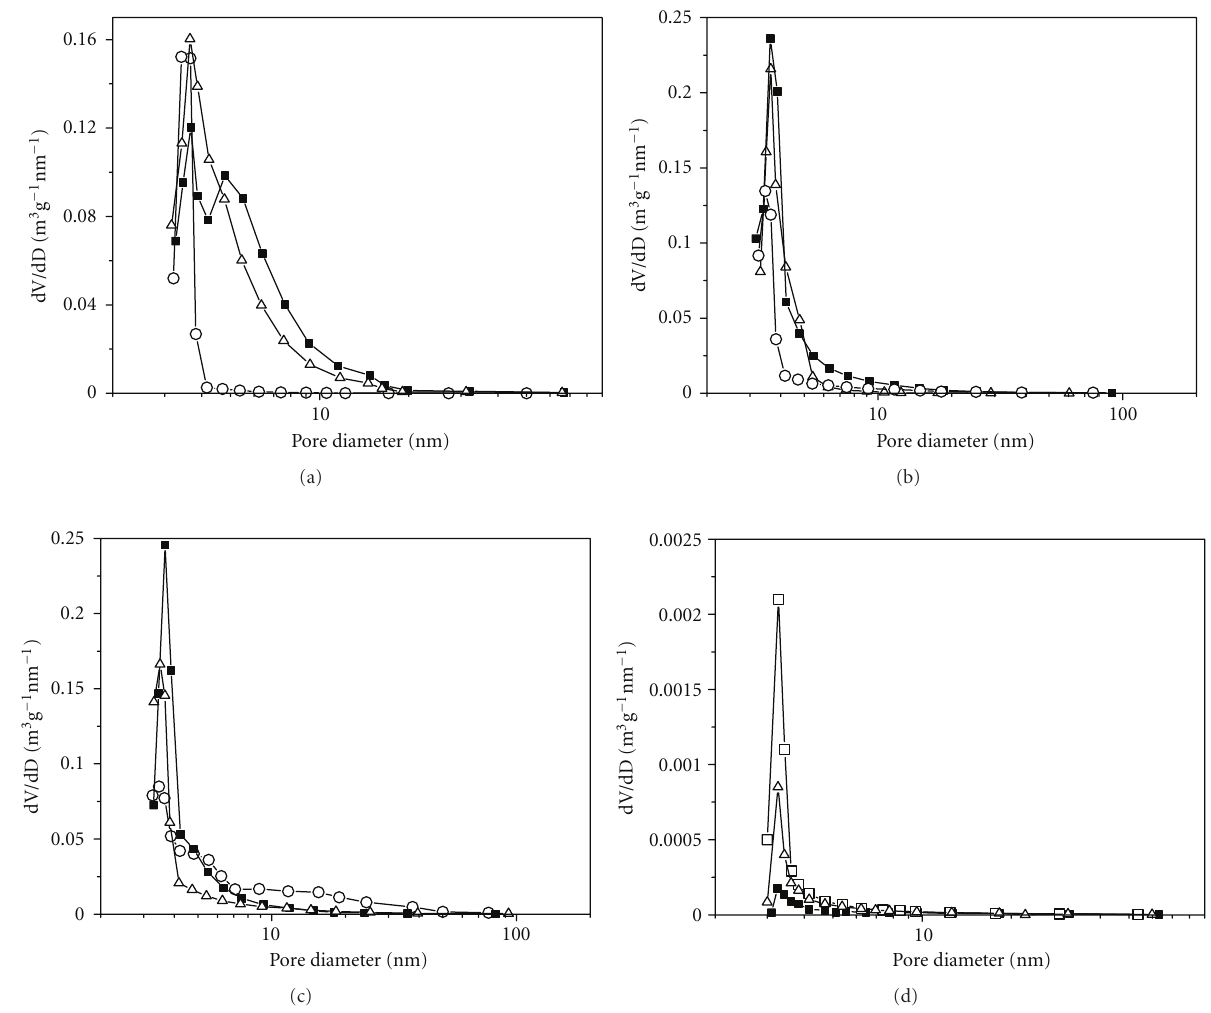
Figure 2: Di ff erential curves of the pore size distribution in series 1 samples obtained by hydrolysis of TiCl 4 under the following conditions: (a) samples 1.1–1.3, T = 4 ◦ C; (b) samples 1.4–1.6, T = 20 ◦ C; (c) samples 1.7–1.9, T = 70 ◦ C (pH: (cid:3) —3 ÷ 4, (cid:2) —6 ÷ 7, (cid:3) —9 ÷ 10); and (d) series 3 samples obtained by hydrolysis of TIP ( T synthesis : (cid:2) —50 ◦ C, (cid:3) —70 ◦ C, (cid:4) —95 ◦ C). Pore size distribution was determined by BET.